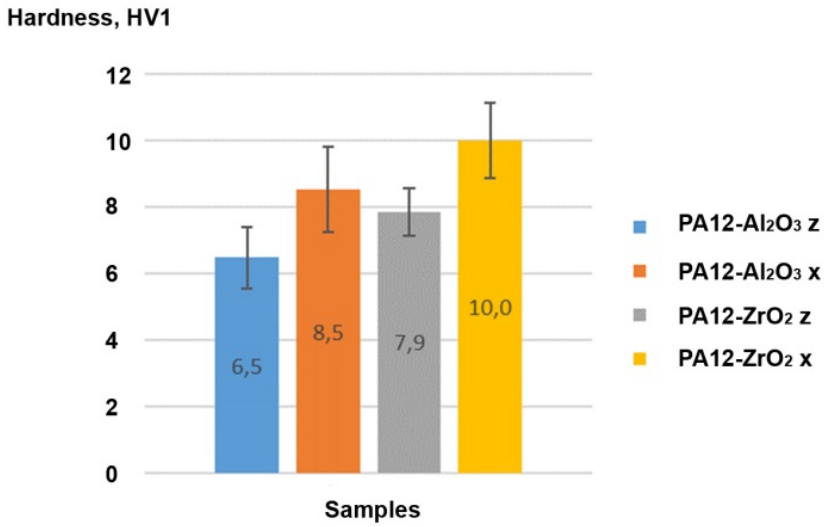
Figure 14. Vickers hardness of the PA12-Al 2 O 3 and PA12-ZrO 2 composites in z and x directions. Soaking Test